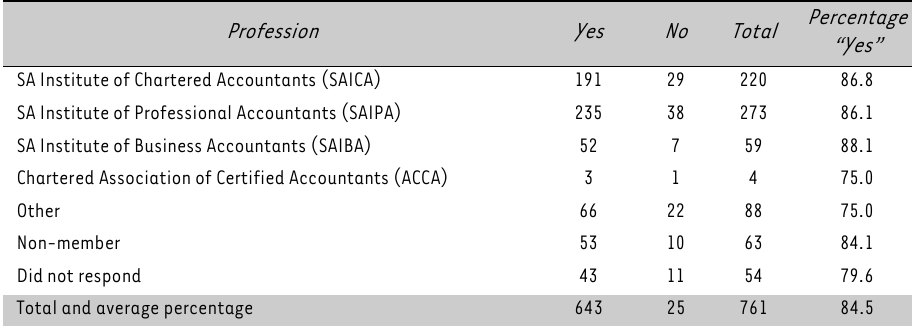
TABLE 10.1: Need for legal backing, analysed by